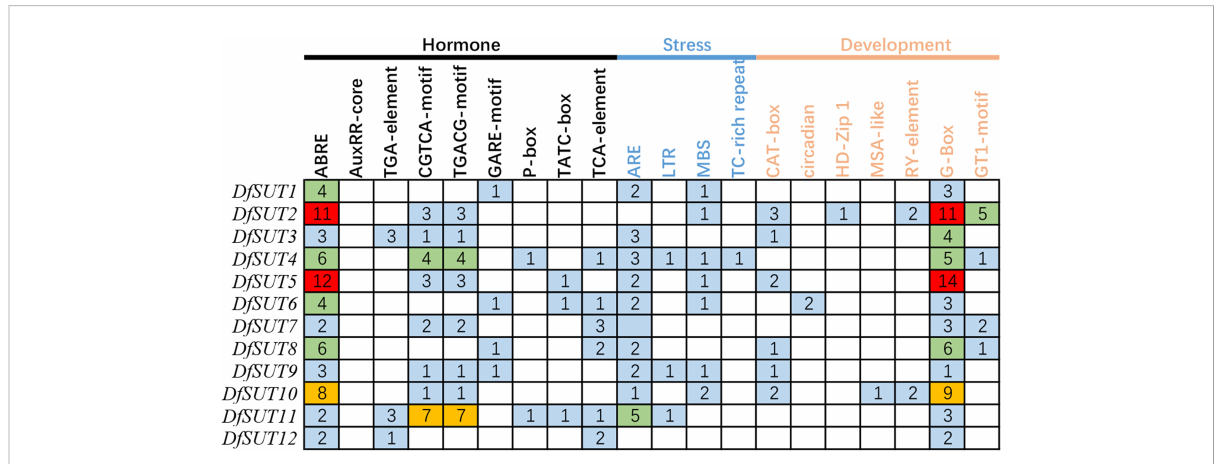
FIGURE 3 The cis -regulatory elements involved in phytohormone, development, and stress responses in the upstream regions of DfSUT gene promoters. ABRE, abscisic acid-responsive element; AuxRR core and TGA element, auxin-responsive element; CGTCA-motif and TGACG-motif, MeJA- responsive elements; GARE-motif, P-box and TATC-box, gibberellin-responsive elements; TCA element, salicylic acid-responsive elements; ARE, involved in anaerobic induction; LTR, low temperature-responsive element; MBS, TC-rich repeats, involved in defense and stress response; CAT box, circadian, HD-Zip I, MSA-like, and RY-element involved in meristem expression, circadian control differentiation of the palisade mesophyll, cell cycle regulation, and seed-speci fi c regulation, respectively; G-box, GT1-motif, light-responsive elements.